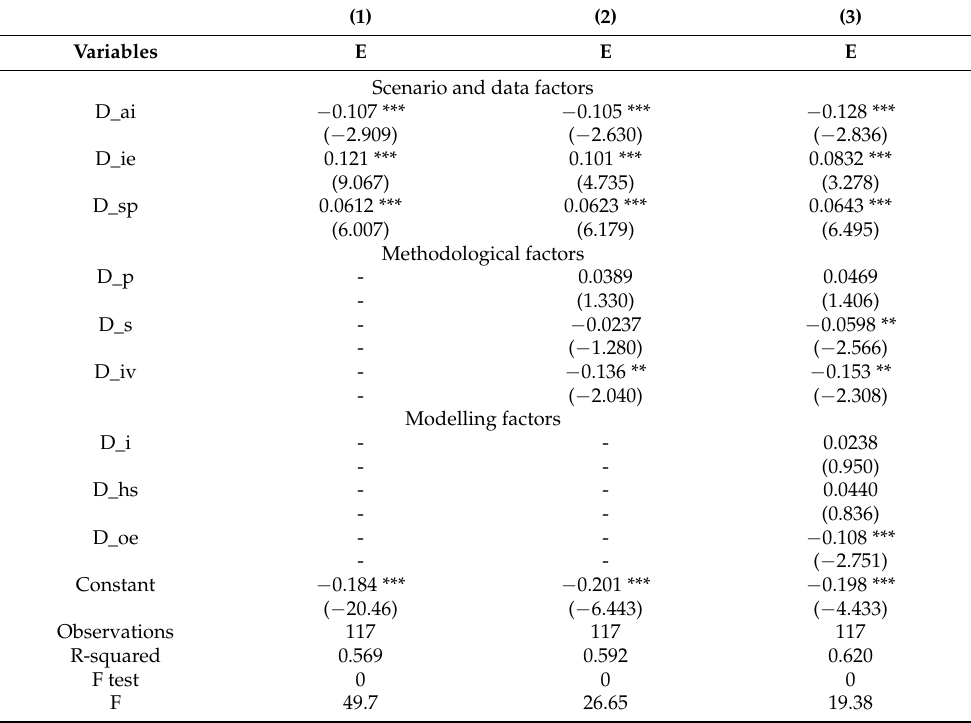
Table 6. Meta-regression analysis results (elasticity).